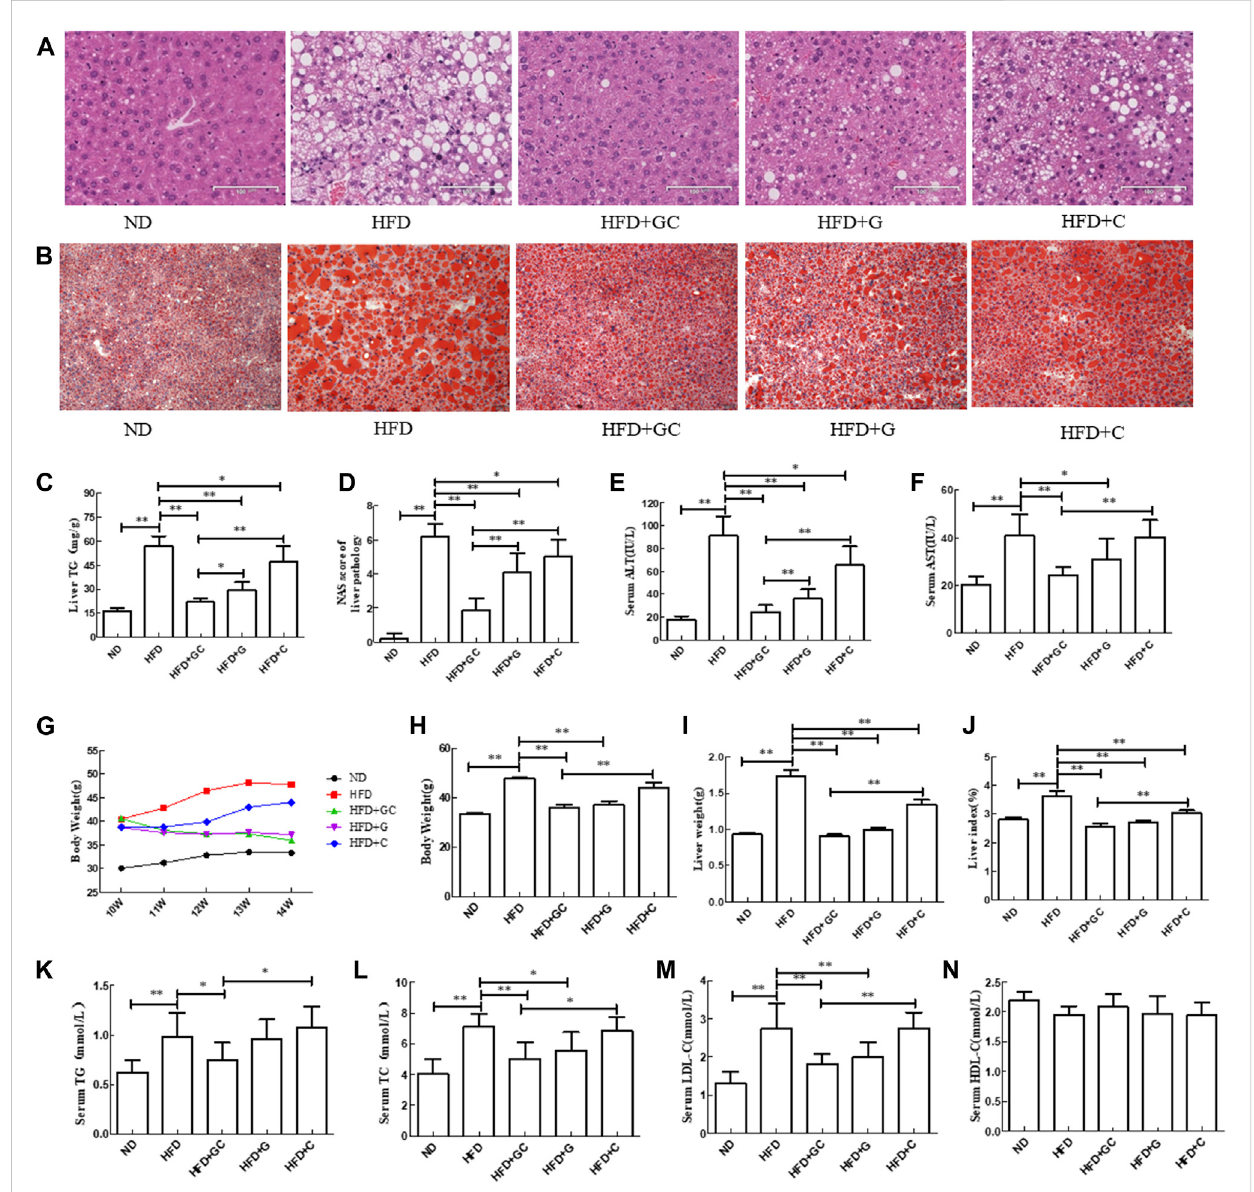
FIGURE 1 Changes in liver histology as well as biochemical indexes of liver and serum in a mouse NAFLD model with intervention of geniposide, chlorogenic acid,ortheircombination. (A) H&Estaining,×200. (B) OilredOstaining,×200. (C) LiverTGlevel. (D) LiverNAS. (E) SerumALTlevel. (F) SerumASTlevel. (G) Mousebodyweight. (H) Mousebodyweight. (I) Mousewetliverweight. (J) Mouseliverindex,wetliverweight/bodyweight×100%. (K) SerumTGlevel. (L) SerumTC level. (M) SerumLDL-Clevel. (N) Serum HDL-C level.Abbreviations:ND,normal diet;HFD,high-fat diet;GC,geniposide andchlorogenic acid combination treatment; G, geniposide treatment; C, chlorogenic acid treatment; TG, triglyceride; ALT, alanine aminotransferase; AST, serum aspartate aminotransferase; NAFLD, non-alcoholic fatty liver disease; H&E, hematoxylin and eosin; NAS, NAFLD activity score. * p < 0.05 and ** p < 0.01 ( n = 10 per